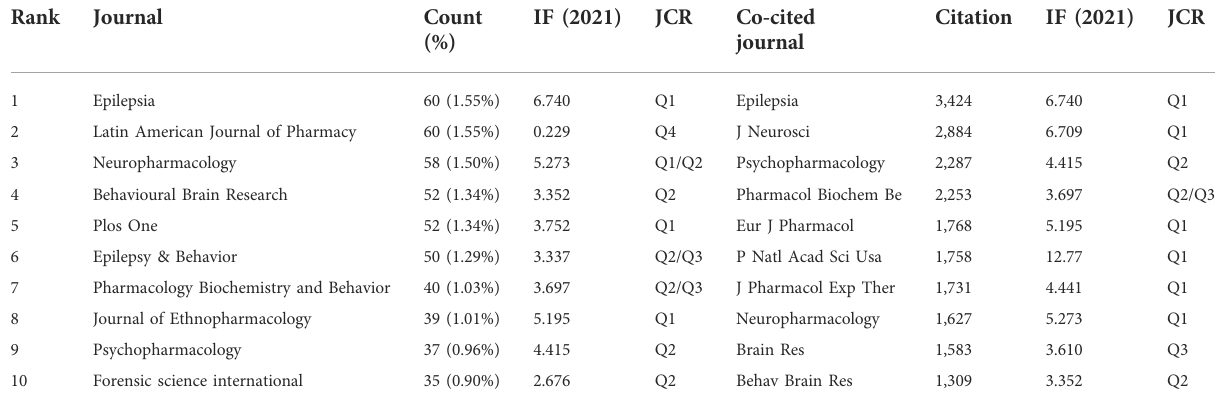
TABLE 3 Top 10 journals and co-cited journals publishing diazepam research articles. IF, Impact Factor; JCR, Journal Citation Reports.